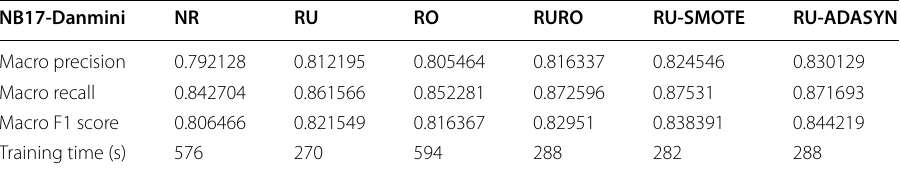
Table 41 ANN Classification results for NB17-Danmini on AWS with Spark for various resampling methods